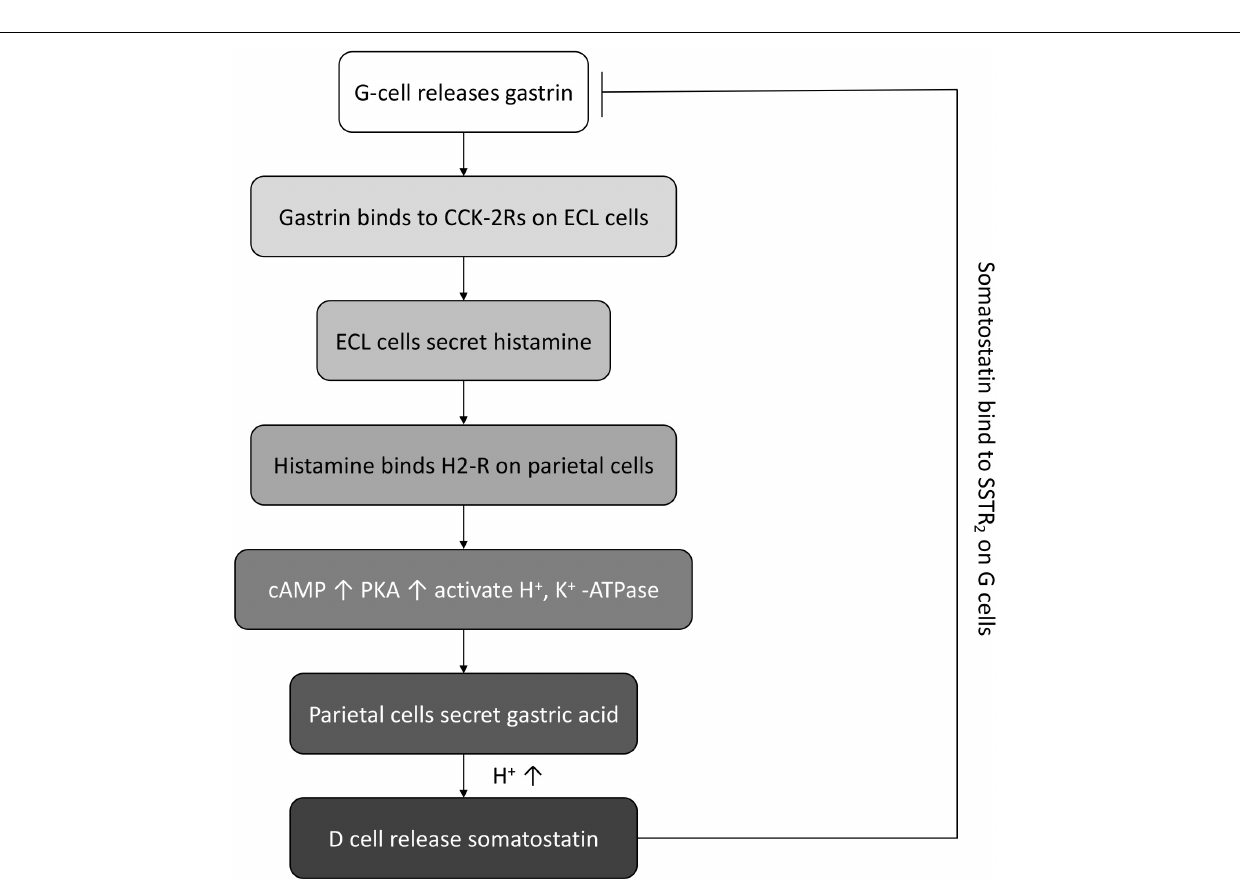
Frontiers in Medicine |